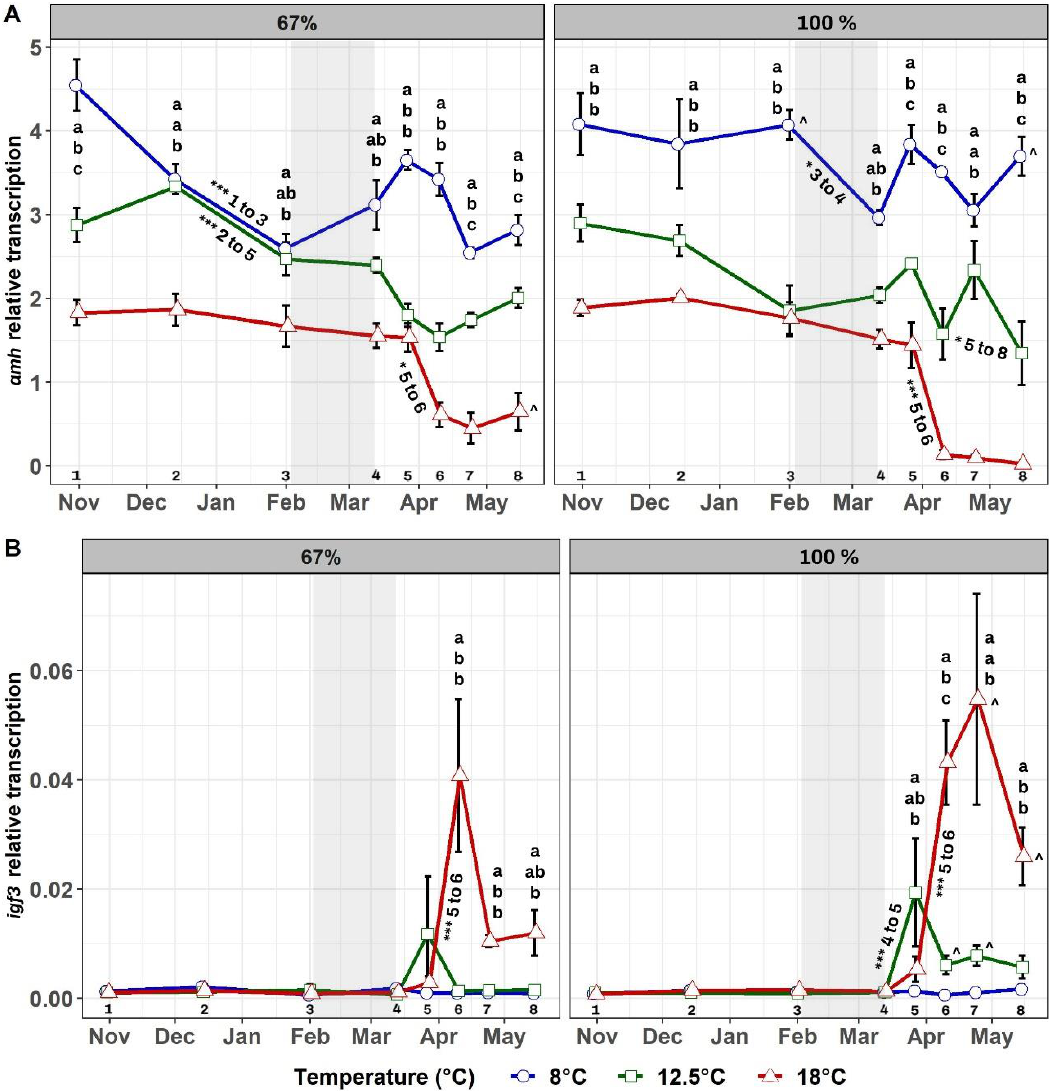
Figure 6. Mean testis amh ( A ) and igf3 ( B ) transcription over time in the six experimental groups. Feeding regimes are displayed separately, with the 67% groups shown on the left and the 100% ration groups on the right. The grey-shaded area shows the duration of the LD12:12 winter signal. Letters “a”, “b”, and “c” indicate significant differences ( p < 0.05) between groups within a feeding regime for a given time. Signs “ˆ” indicate significant differences ( p < 0.05) between groups reared at the same temperature but at different feeding regimes at a given time, and they are located next to the largest value of the pair. Numbers from 1 to 8 at the bottom of the graphs represent the sampling number and aid with an explanation of significant differences over time within each group. These are displayed with asterisks as follows: (*) p -value < 0.05 and (***) p -value < 0.001. Asterisks are located next to the corresponding line and are followed by the sampling numbers between which such significant difference occurred.